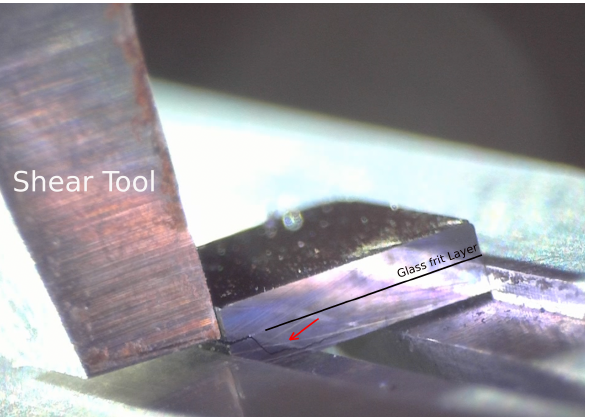
Figure 14. Crack propagation in the silicon layer for category C as captured by a DinoLite microscope. The arrow points to the crack